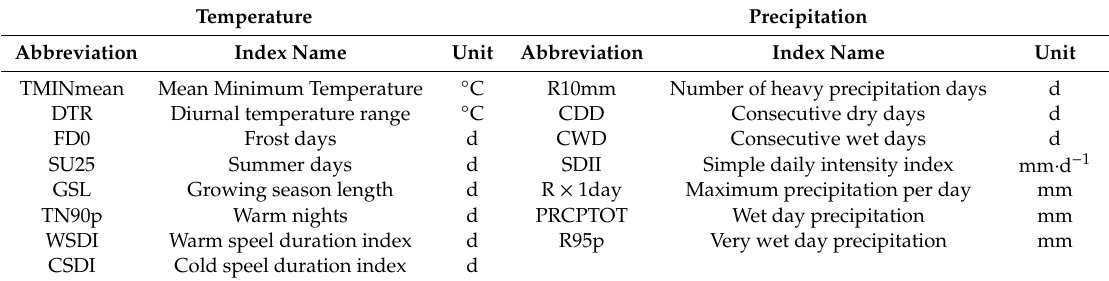
Table 1. Definitions of extreme climate indices used in this